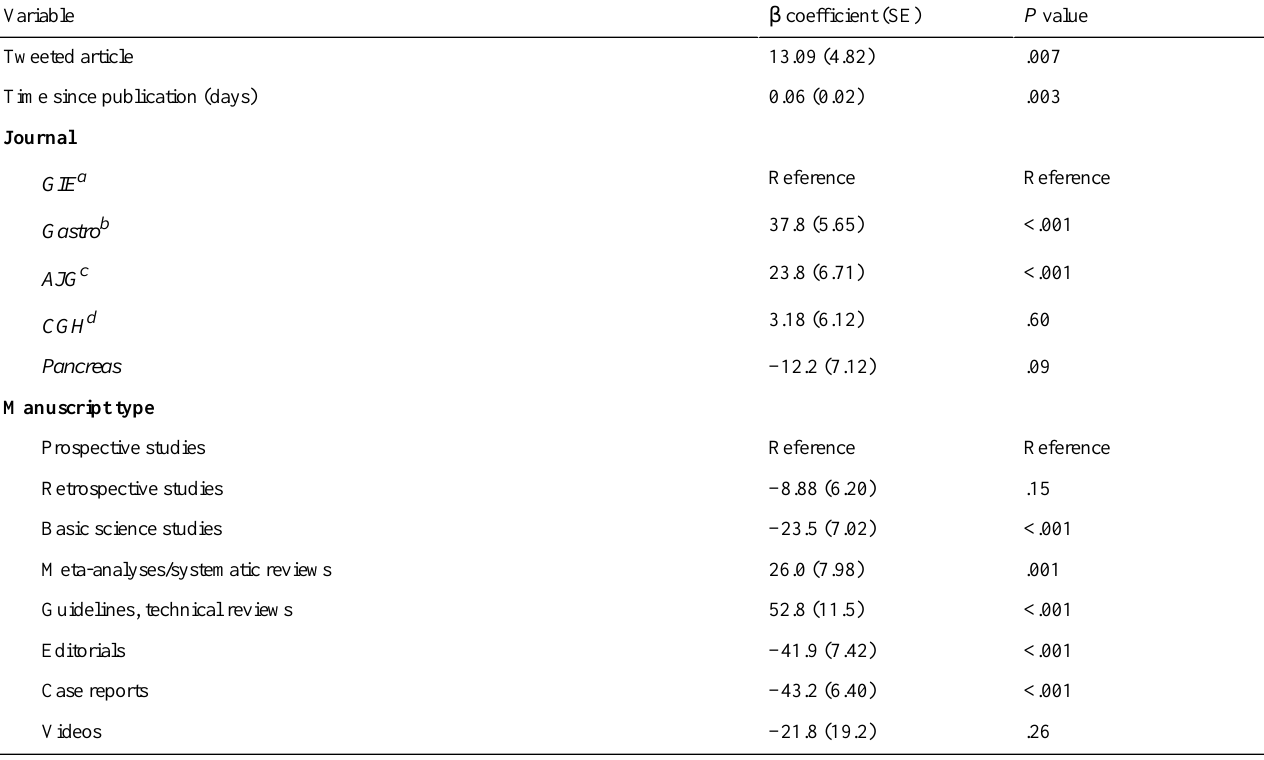
Table 2. Multivariate linear regression analysis assessing the predictors of the number of Google Scholar citations among all articles published by five major gastroenterology journals in 2012 (N=1666, tweeted